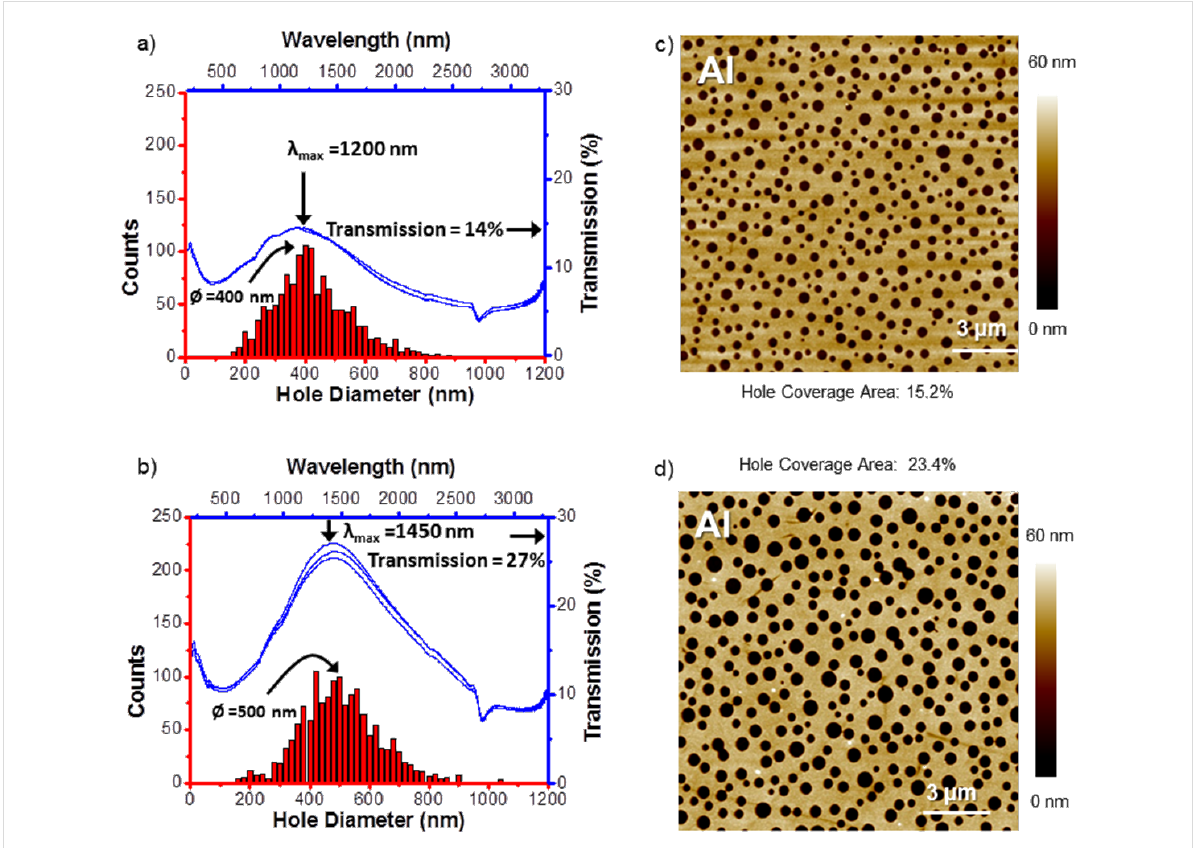
Figure 4: Optical transmission due to localized surface plasmonic resonance (blue) of perforated aluminum films with two different hole size distributions (red). Top: smaller holes (PS/PMMA mass ratio 3:7) with a hole coverage area of 15.2%, bottom: larger holes (PS/PMMA mass ratio 4:6) with a hole coverage area of 23.4%. a) and b): The hole size distributions are shown with red columns, the data are the summarization of five 15 μ m × 15 μ m AFM images taken at randomly selected positions. The optical transmission spectra, taken at various sample positions, are plotted as blue line graphs. The representative AFM topography (tapping mode) of the samples is shown in c) and d).